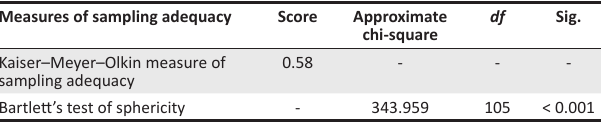
TABLE 2: Demographics of the sample ( n = 80). Demographic